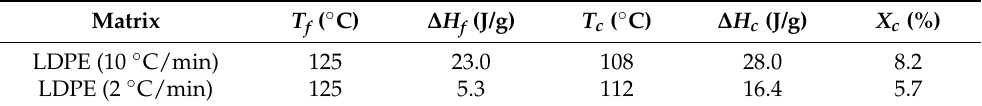
Figure 7. DSC curves of LDPE at a rate of ( a ) 10 °C/min (top) and ( b ) 2 °C/min (bottom). Table 1. LDPE parameters obtained by DSC. Matrix